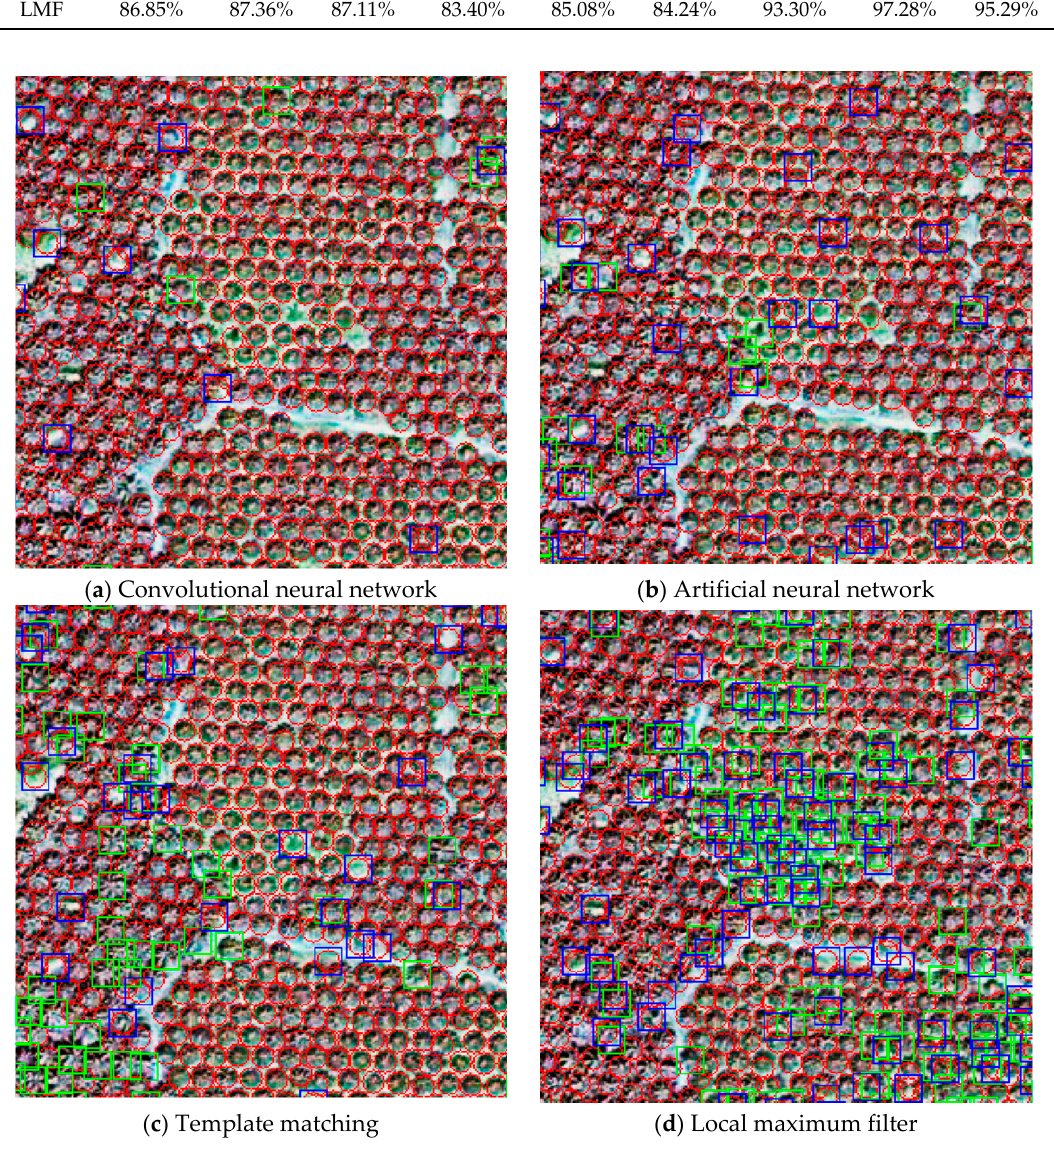
Figure 7. Detection image of each method for region 2 (extracted area).